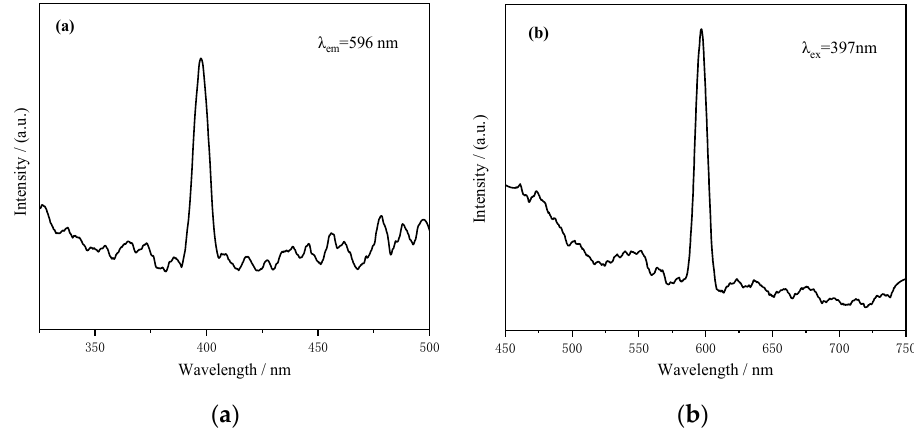
Figure 10. Excitation spectra ( a ) and emission spectra ( b ) of the YMn 2 O 5 sample.